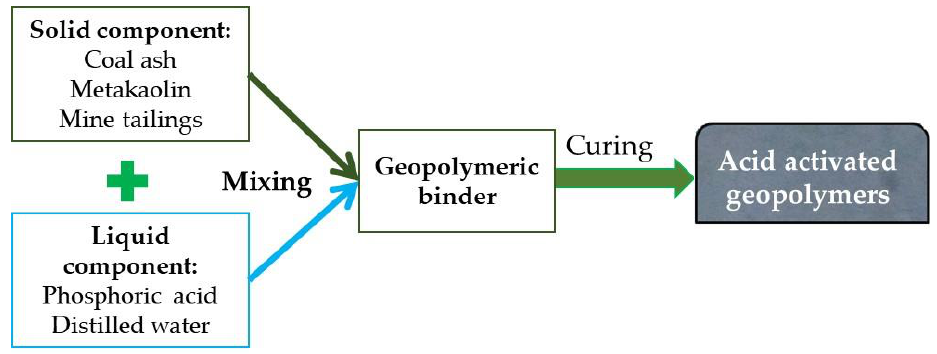
Figure 2. Process flow diagram of the obtained samples.